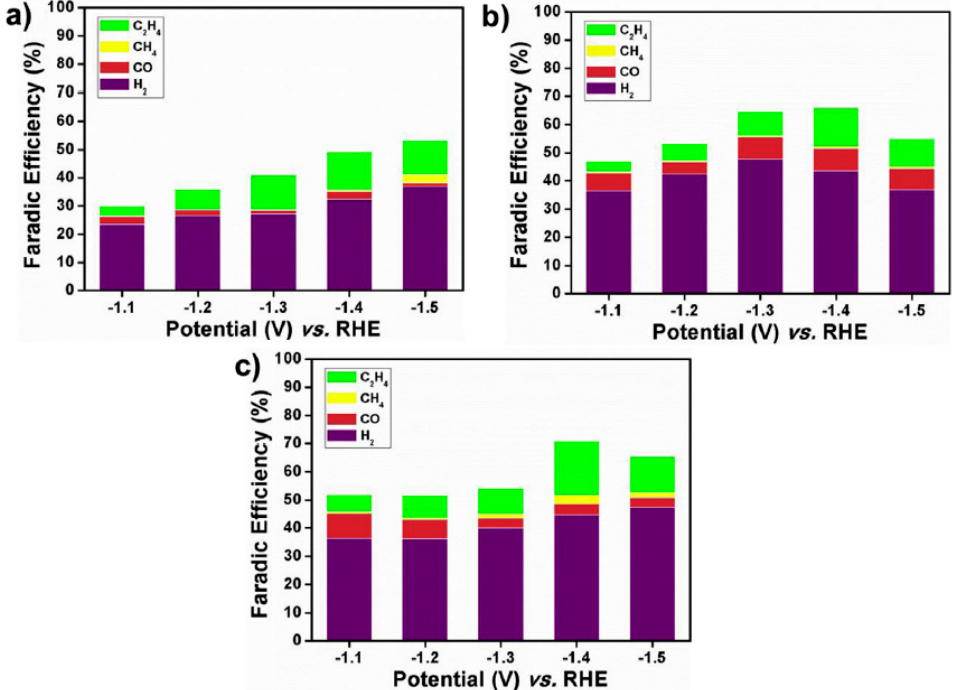
Figure 8. Faradaic efficiency of the gas products for ( a ) Cu 2 O, ( b ) Cu 2 O/rGO, and ( c ) Cu 2 O/N-rGO in a 0.1 M KHCO 3 solution. Reproduced with permission [9].